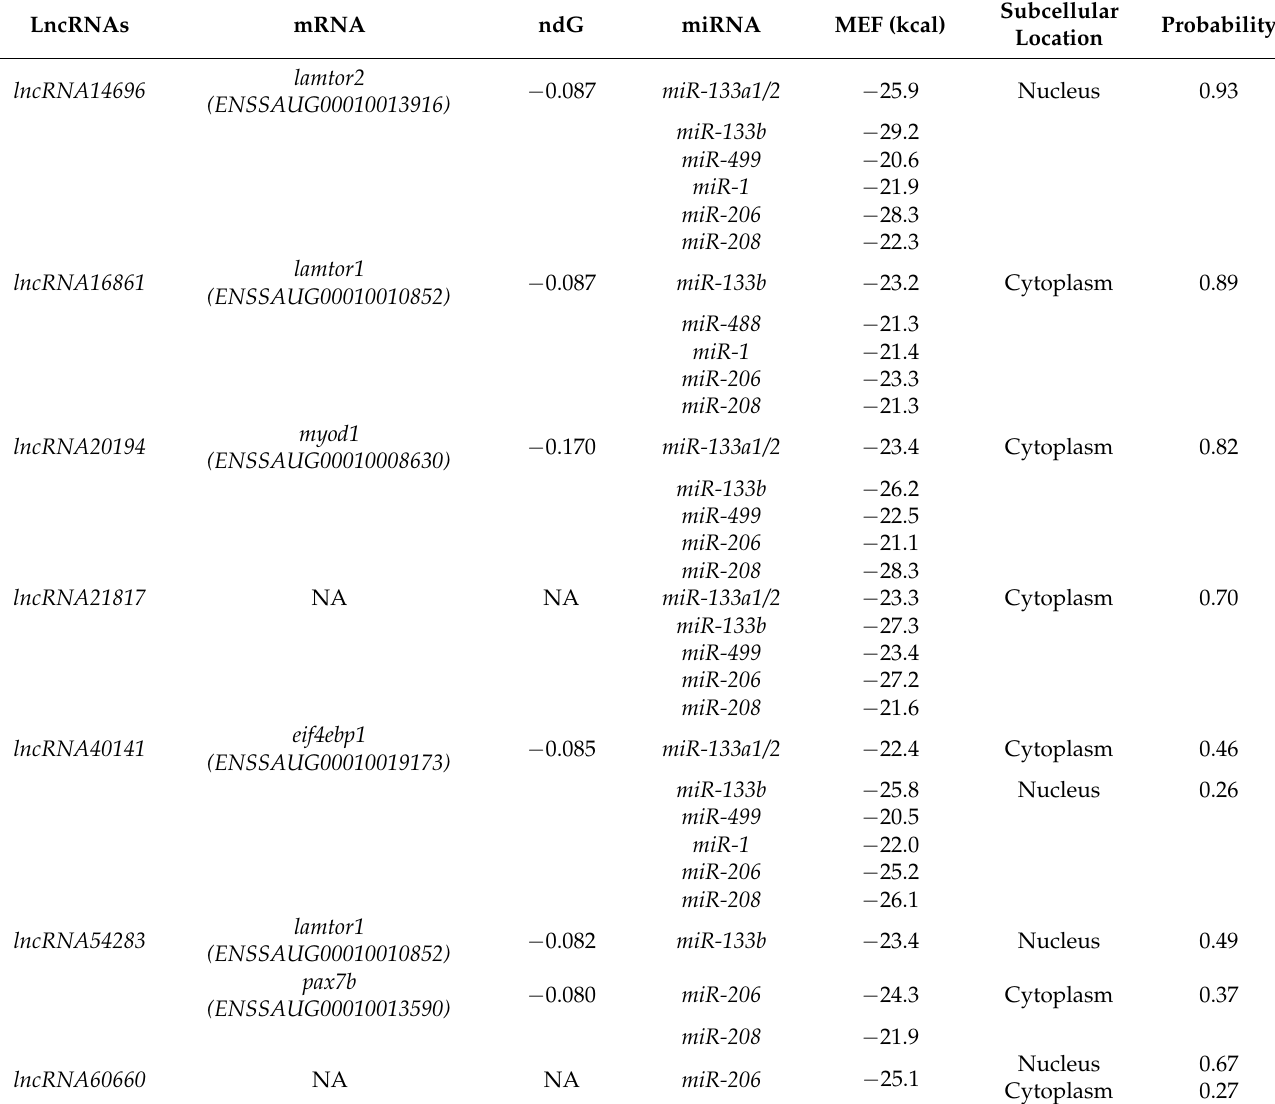
Table 1. Bioinformatic predictions of lncRNA interactions with muscle-related mRNAs and miRNAs and subcellular